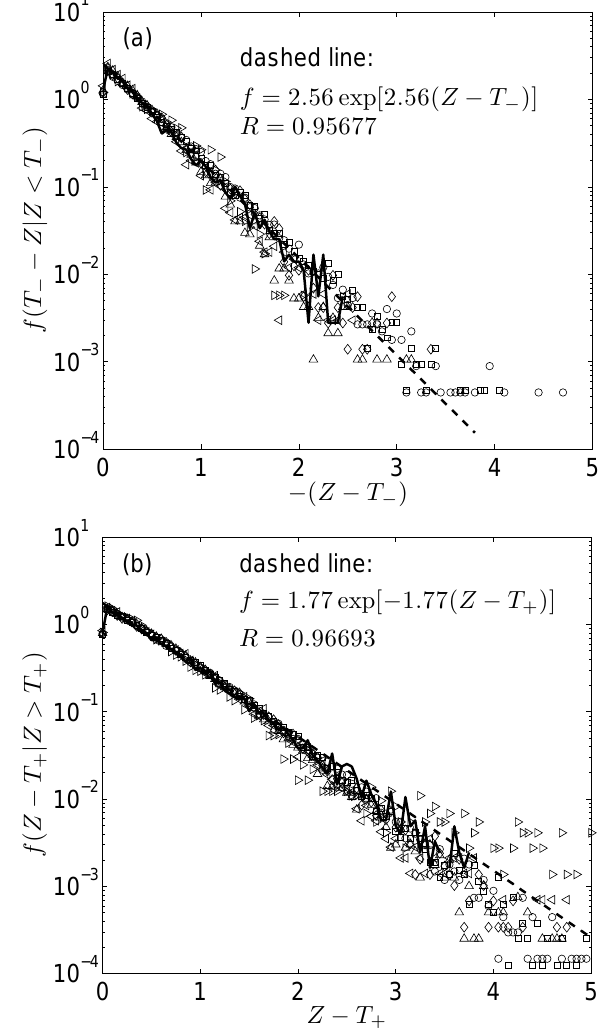
Fig. 5. PDFs of excess amplitudes of dimensionless extreme verti-